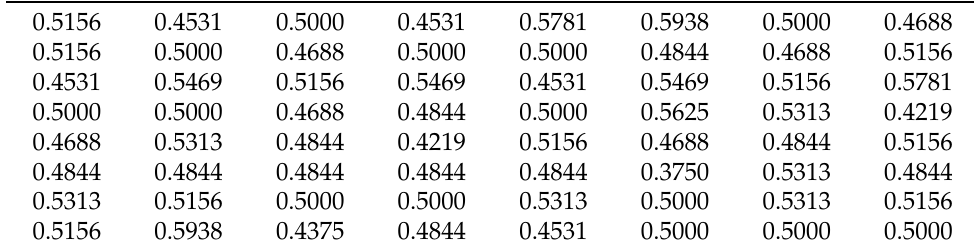
Table 4. Dependence matrix of the proposed S-box.